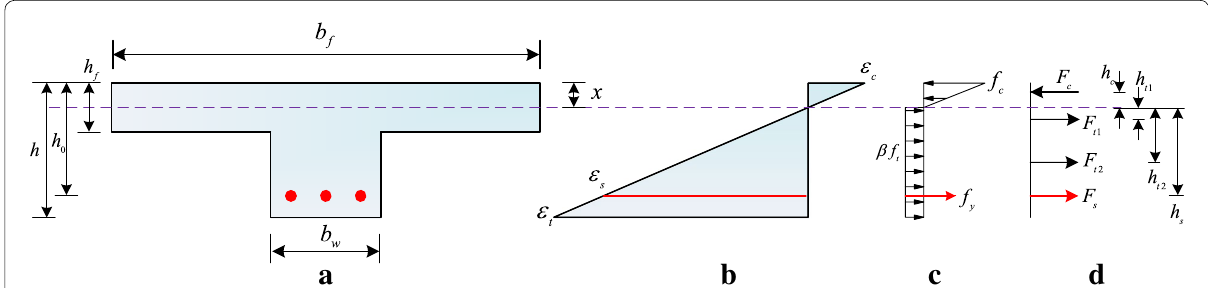
Fig. 22 Diagram of the calculation of ultimate load: a cross-section; b strain distribution; c equivalent stress distribution; d equilibrium of